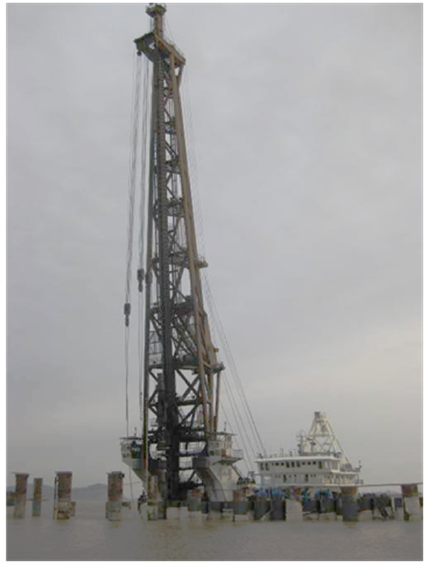
Figure 13. Piling ship “Yangshanhao”.